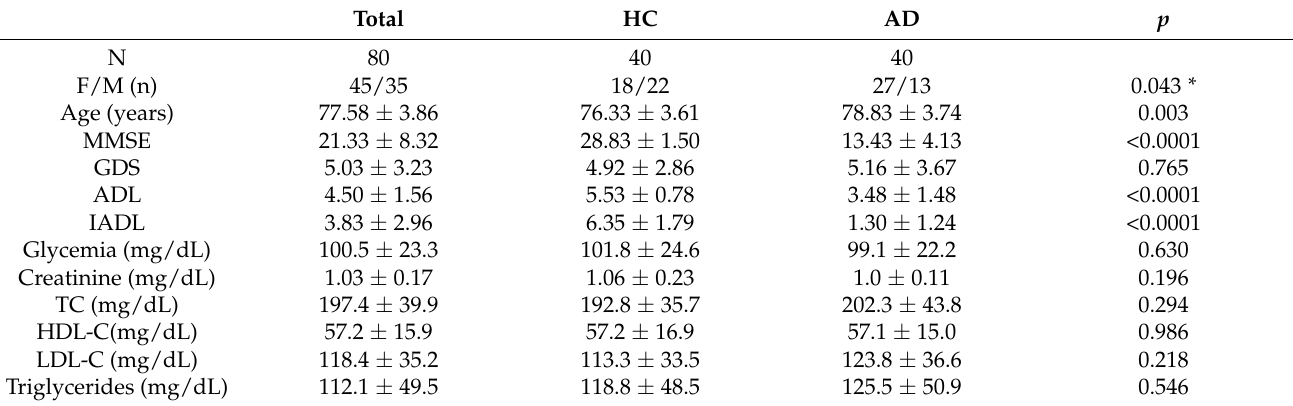
Table 1. Clinical characteristics of all sample population (n = 80) and stratified by groups. Data